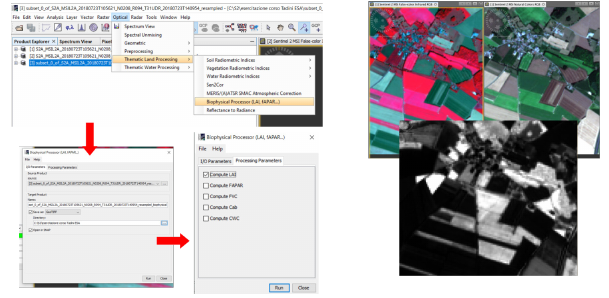
Figure 5. LAI estimate by using the SNAP Biophysical